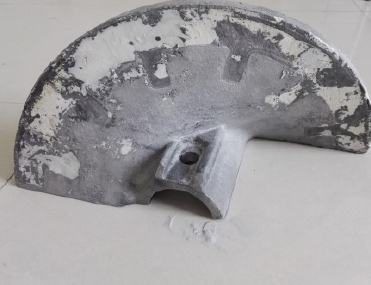
Figure 3. Cast spiral blade. Table 1. Matrix composition.